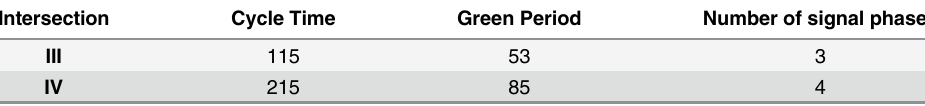
Table 4. Characteristics of Intersections.